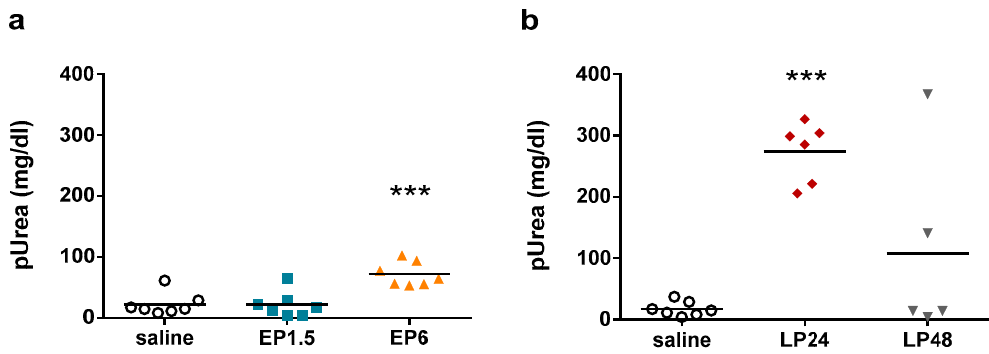
Figure 3. Plasma urea levels in saline- and LPS-treated mice. ***: p ≤ 0.001. ( a ) EP1.5 and EP6 groups. ( b ) LP24 and LP48 groups.